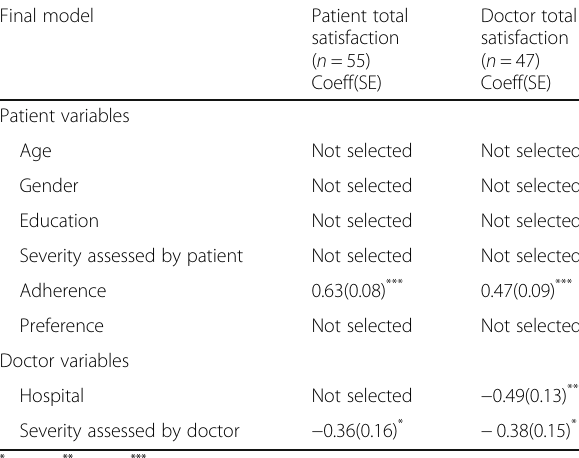
Table 5 Predictors of Patient and Doctor Satisfaction, Using Multilevel Multiple Regression